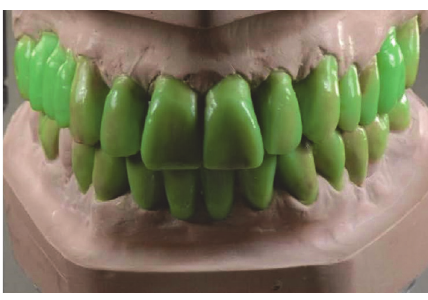
Figure 7: Diagnostic wax-up, frontal